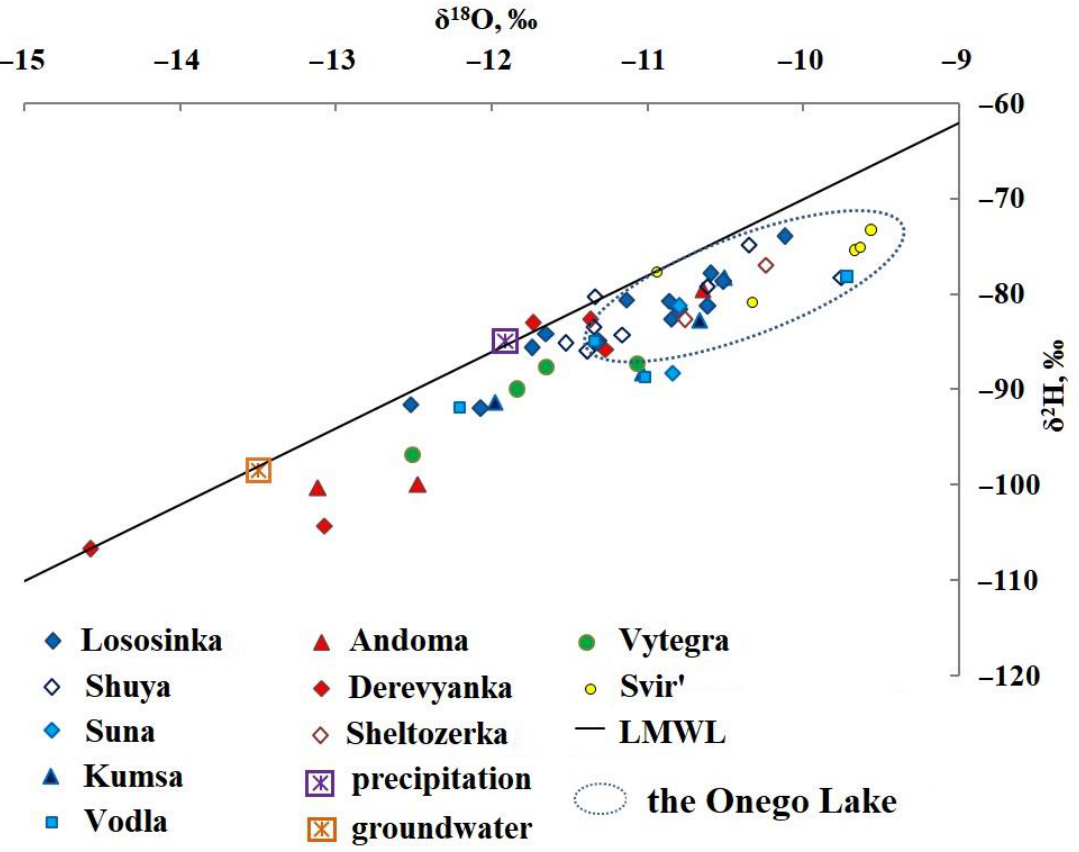
Figure 2. The isotopic composition of the water in the tributaries of Lake Onego.The oval is the main part (95%) of the water samples of Lake Onego; the precipitation is the weighted mean of the isotope composition; and the groundwater is the arithmetic average of756 samples (approximately87% from the FCS and the remaining from the EEP area).